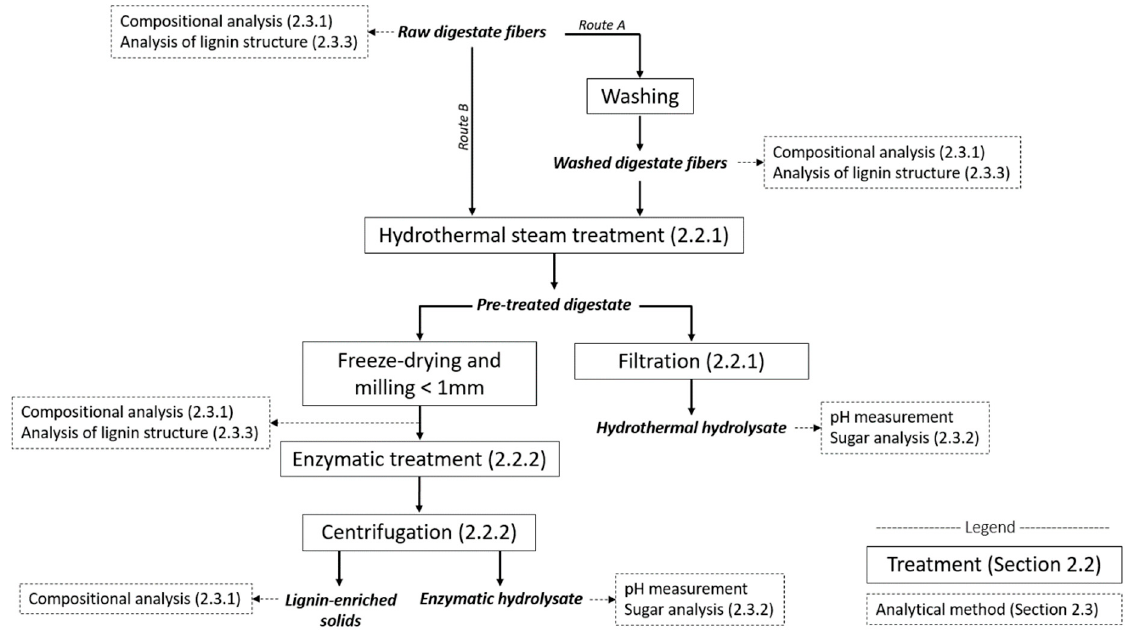
Figure 1. Schematic representation of the experimental procedure with the treatment methods carried out and the analytical methods used, each with reference to the corresponding Section (in brackets), in which the corresponding method is described in more detail.